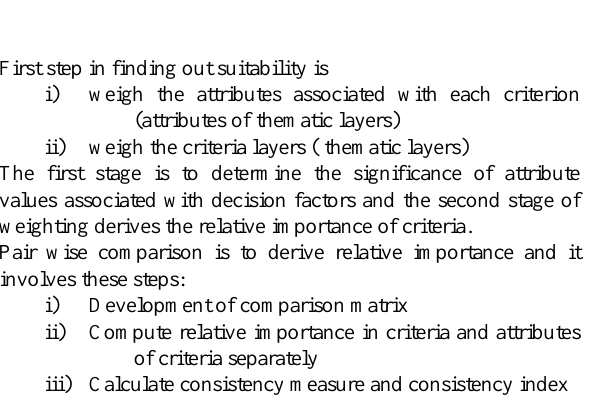
Fig 6: Methodology for AHP